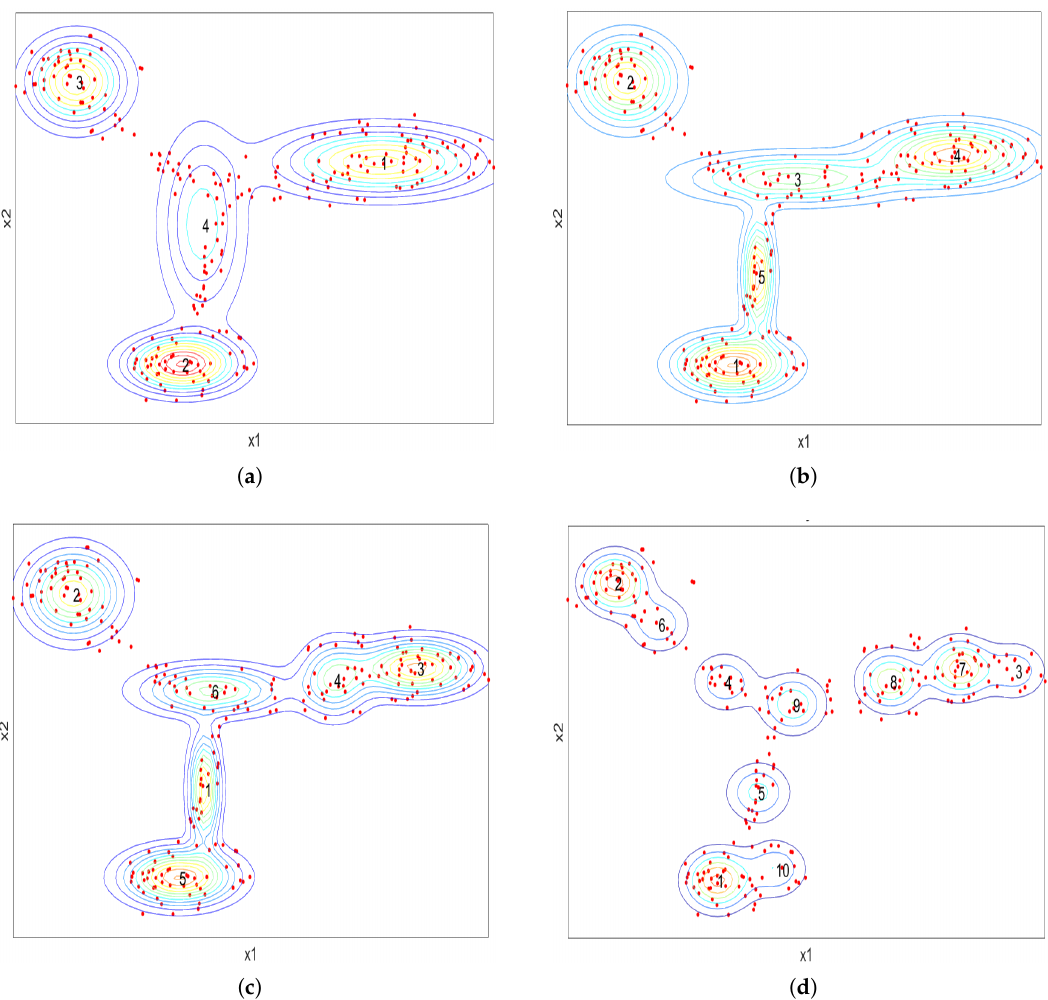
Figure 7. Gaussian mixture models and the corresponding probability contours of CSI and DoA feature vectors in the Hallway area of the simulated indoor environment. ( a ) Hallway GMM with four clusters, ( b ) Hallway GMM with five clusters, ( c ) Hallway GMM with six clusters, ( d ) Hallway GMM with 10